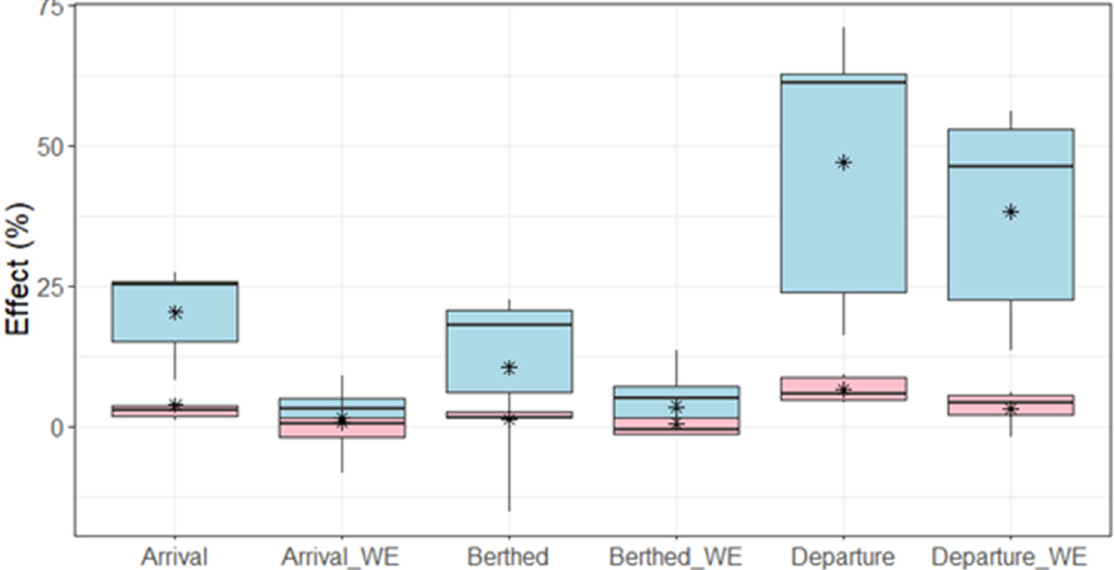
Figure 16. Boxplot of vessel movement effect in % on the hourly mean concentration of NO 2 (blue) and PM 2.5 (pink) using the whole year data and weekends only (_WE). Boxplot showing median effect as a black line with interquartile range and mean with star (*).